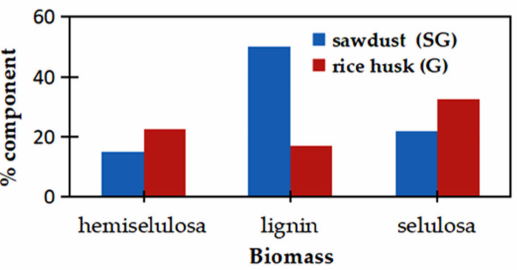
Figure 5. Component of lignocellulose in sawdust and rice husk.